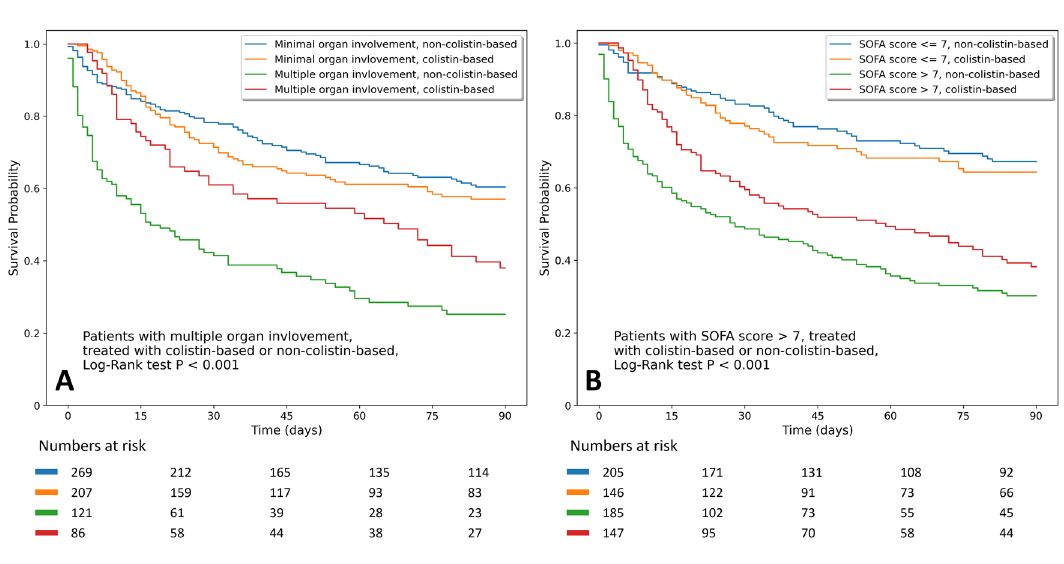
Figure 2. ( a ) Kaplan–Meier survival curves for 90-day mortality stratified by pattern of organ involvement (minimal and multiple) and antimicrobial therapy (colistin-based and non-colistin-based). ( b ) Kaplan–Meier survival curves for 90-day mortality stratified by SOFA score (> 7 and ≤ 7) and antimicrobial therapy (colistin- based and non-colistin-based). SOFA Sequential Organ Failure